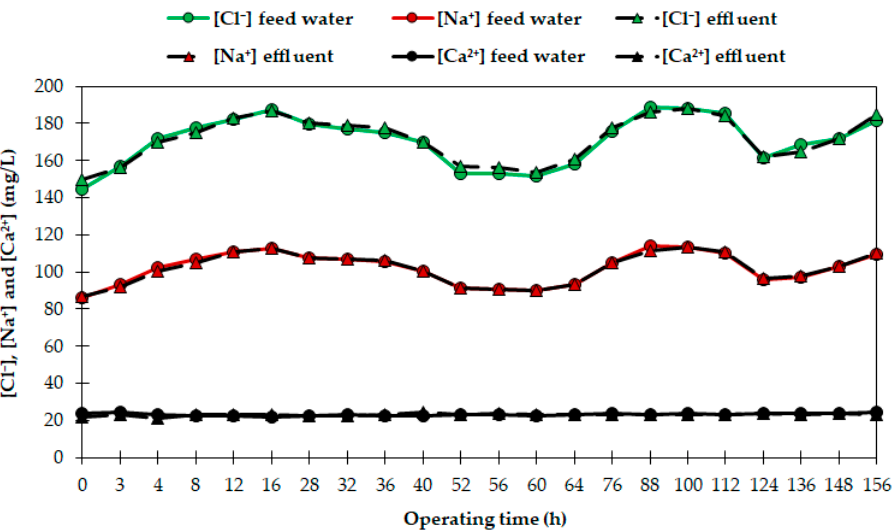
Figure 4. [Cl − ], [Na + ] and [Ca 2+ ] in the feed water and effluent during the tests performed at 26 °C.